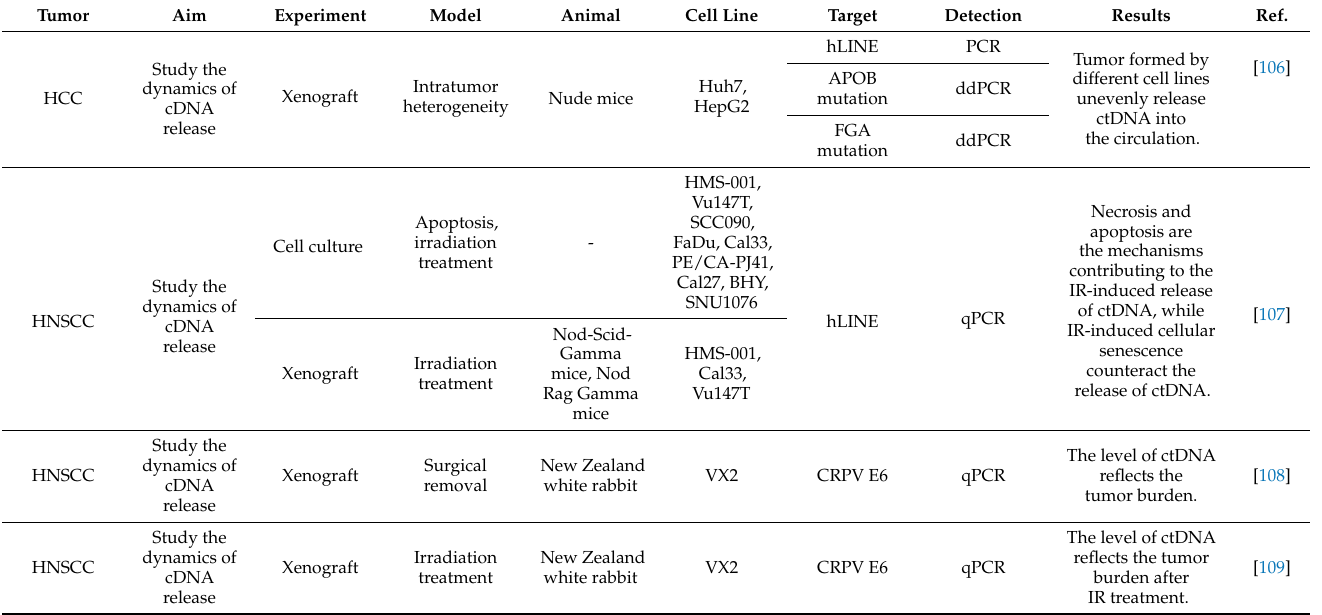
Table 3. Experimental models of ctDNA in virus-related